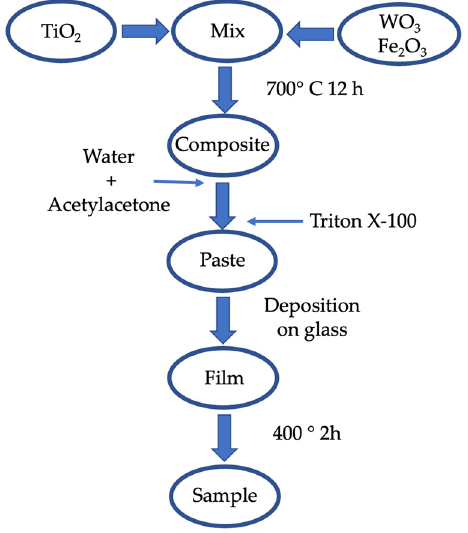
Figure 1. Preparation procedure scheme of TiO 2 -based materials.